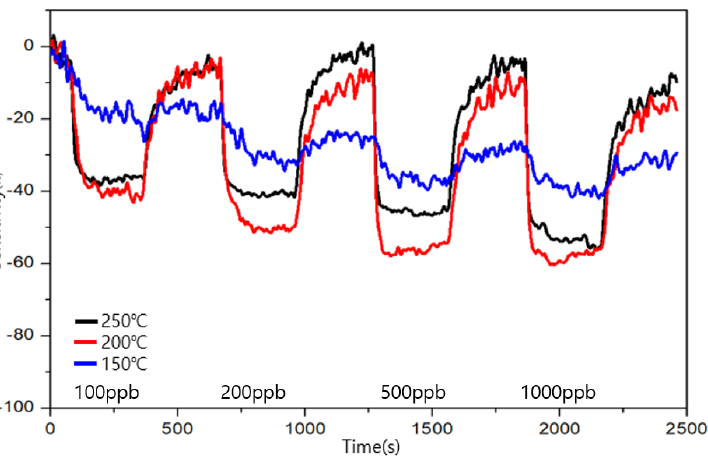
Figure 13. Sensitivity and recovery at different operating temperatures for toluene in the ppb range for the type B sensor.